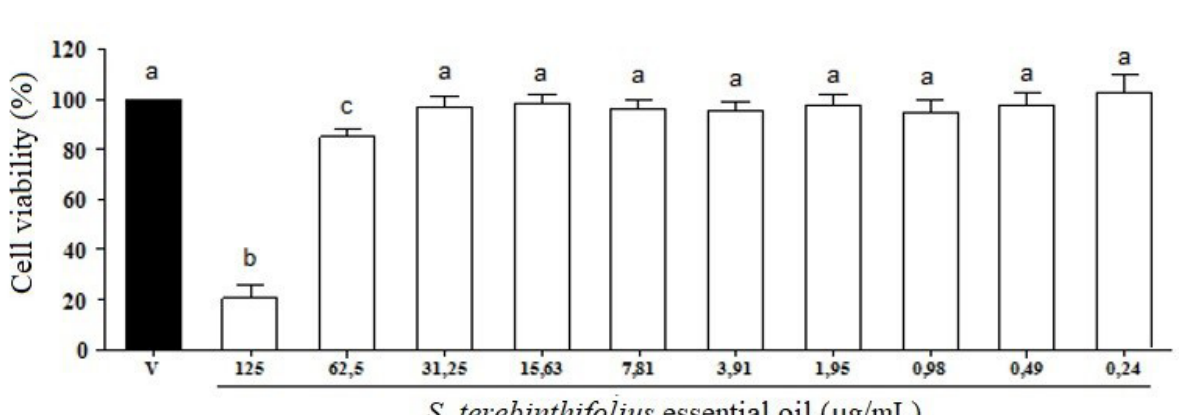
FIGURE 4 - Cell viability percentage of RAW 264.7 macrophages lineage according to the concentration of S. terebinthifolia green fruits